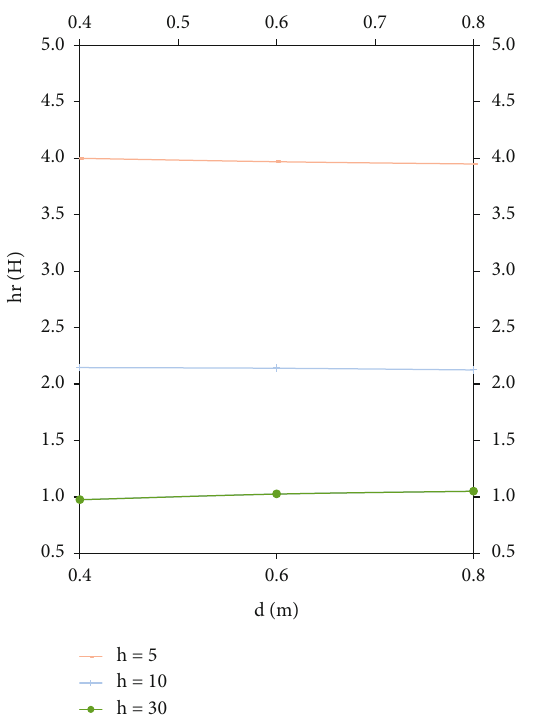
d ) and pile-soil friction coe ffi cient ( δ r ) with pile diameter (